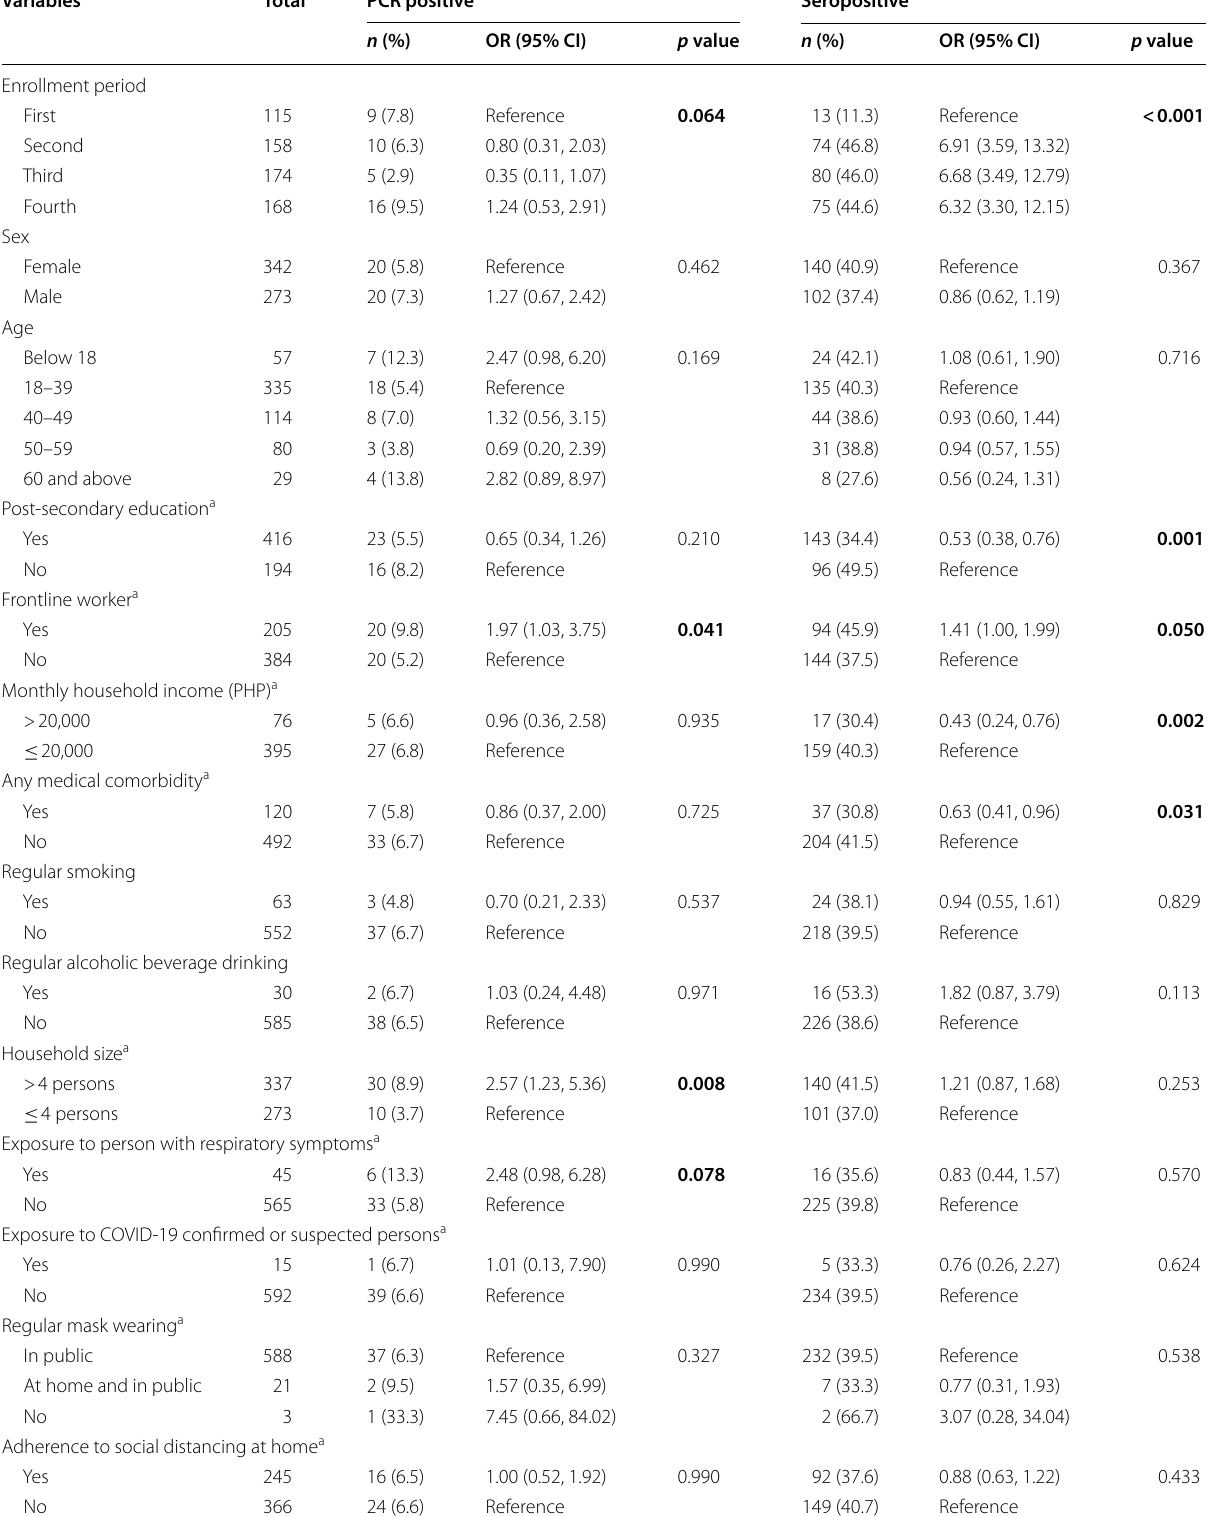
Table 3 Association between baseline characteristics and PCR positivity and seropositivity: univariable logistic regression